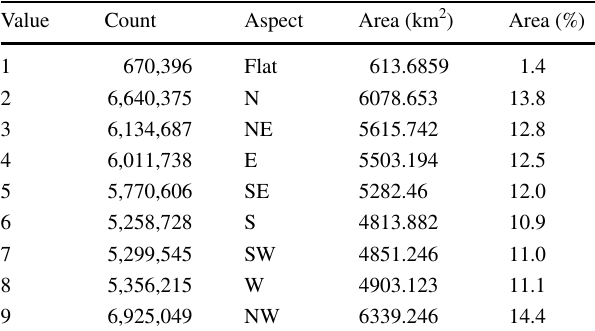
Fig. 7 Aspect map of the Betwa River basin and sub-basins Table 8 Areal extent of aspect in the Betwa River